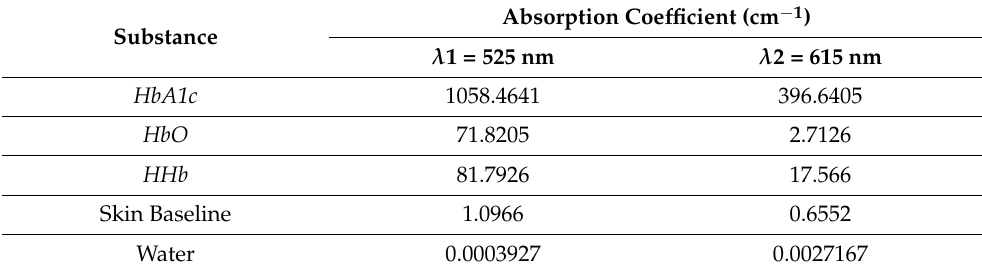
Table 2. Absorption coefficients for the whole finger